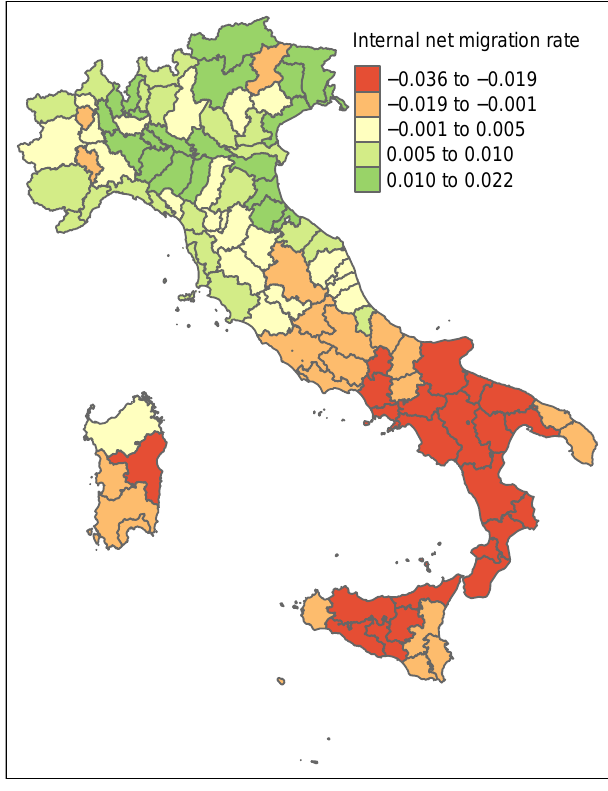
Figure 1: Internal net migration rate from 2002 to 2018 in Italian provinces